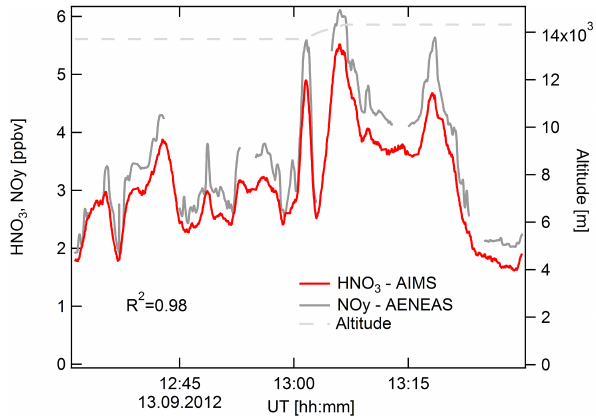
Figure 9. (a) Time series of HNO 3 , measured by AIMS-TG (red) in the Antarctic stratosphere between 33 and 65 ◦ S on 13 Septem- ber 2012, are shown. The dashed line represents the altitude of the aircraft. HNO 3 values are highly variable due to mixing at the edge of the polar vortex and reach values of up to 5.2ppbv. For com- parison, NO y measured by AENEAS is shown in gray. The two measurements show good agreement with a correlation coefficient of R 2 = 0 .